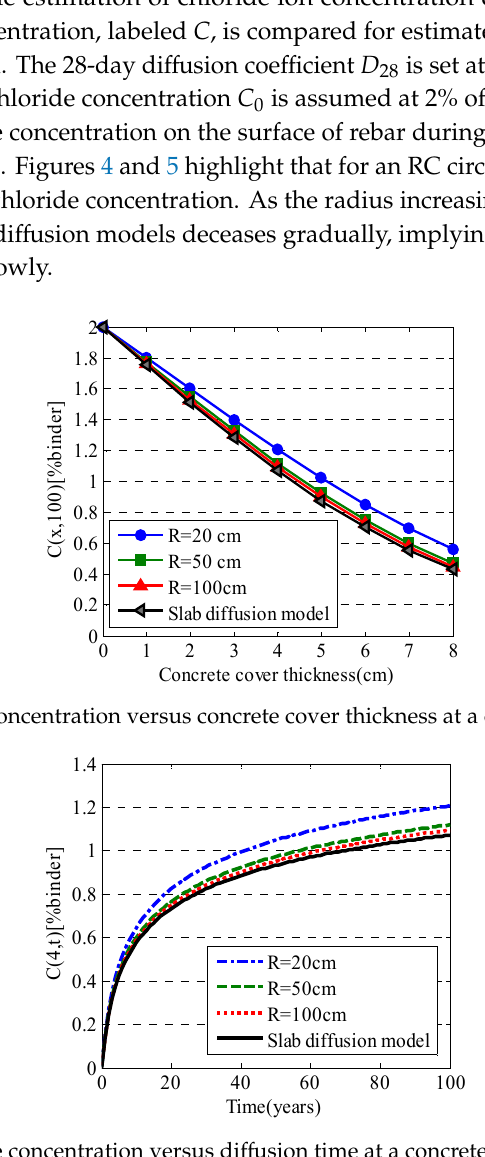
Figure 5. The chloride concentration versus diffusion time at a concrete cover thickness of 5 cm.